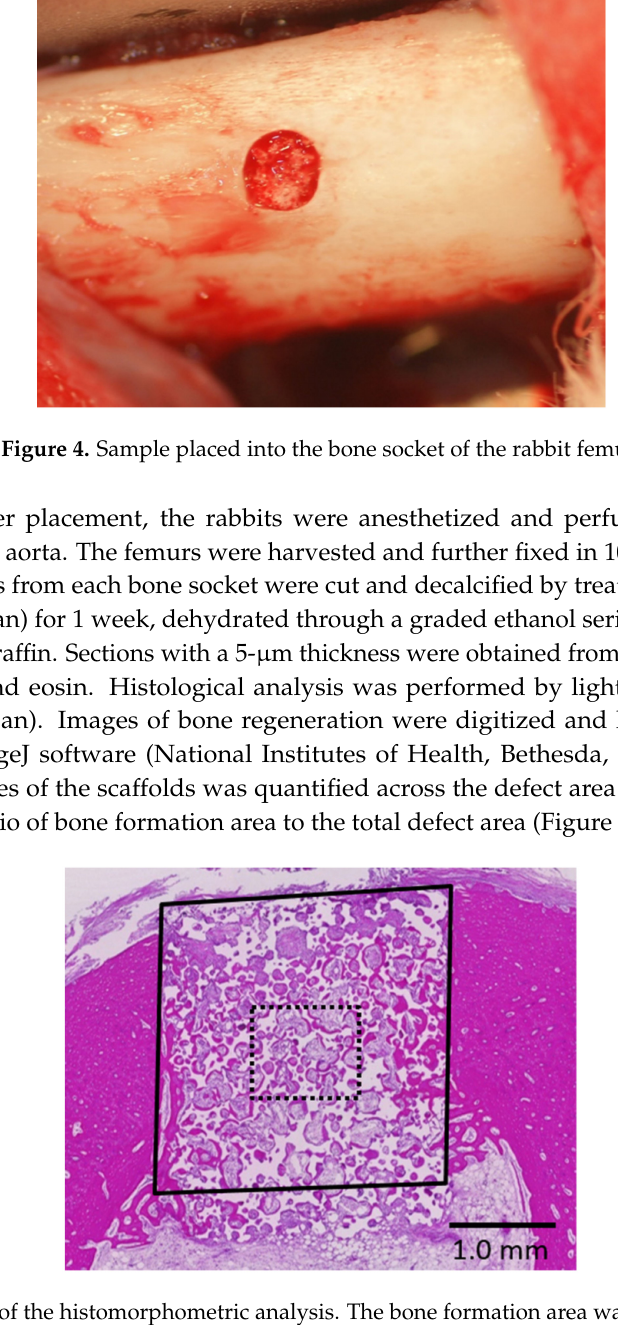
Figure 5. Schema of the histomorphometric analysis. The bone formation area was measured over the whole (solid-line square) and central (dotted-line square) area of the bone defect, calculated as the ratio of the area of newly formed bone to that of formed tissue area in the pores. The empty areas represent the scaffolds that had been removed by